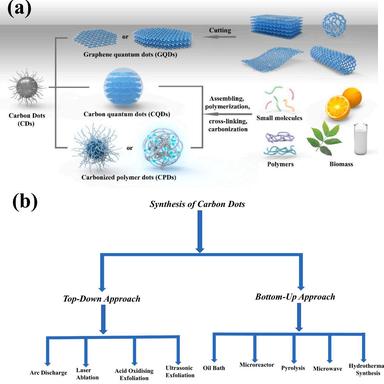
(a) The categorization of carbon dot. Reproduced with permission, and (b) the various approaches that can be adopted to generate carbon dots.